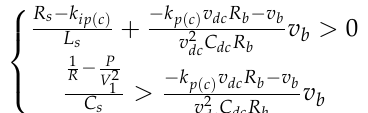
Figure 21. The curves of AC bus voltages and currents in discharging state (Group B).